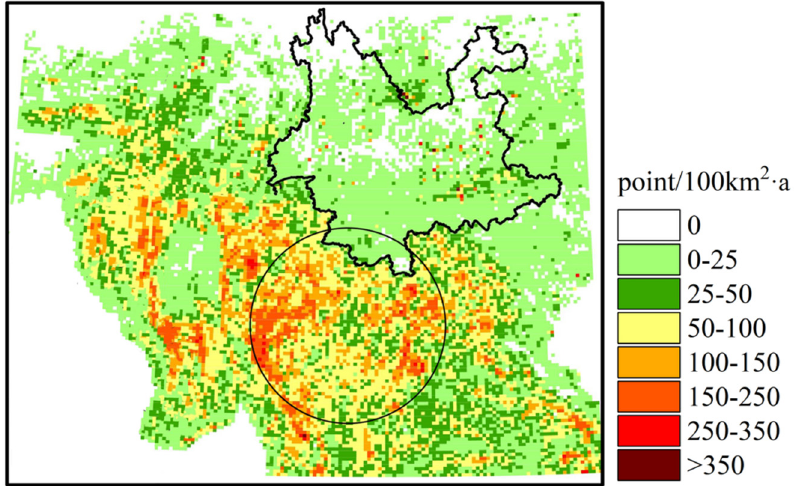
Figure 5. The majority of Southeast Asia (90° to 107° E, 15° to 29° N) has a spatial distribution of the yearly average number of fire spots for biomass combustion from 2017 to